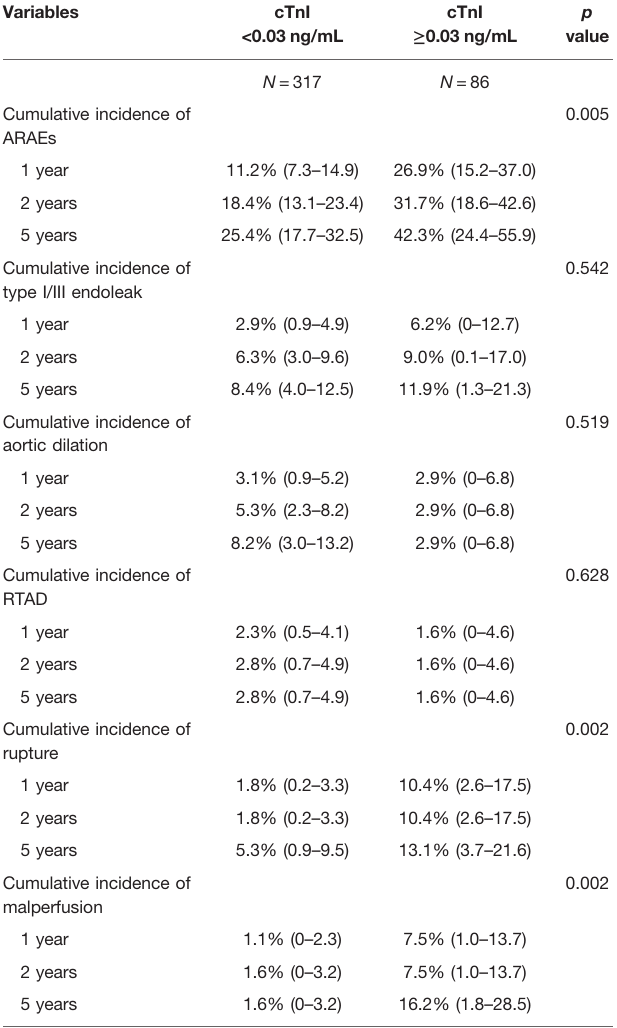
TABLE 5 | Details of 5-year ARAEs strati fi ed with cTnI <0.03 ng/mL and ≥ 0.03 ng/mL.